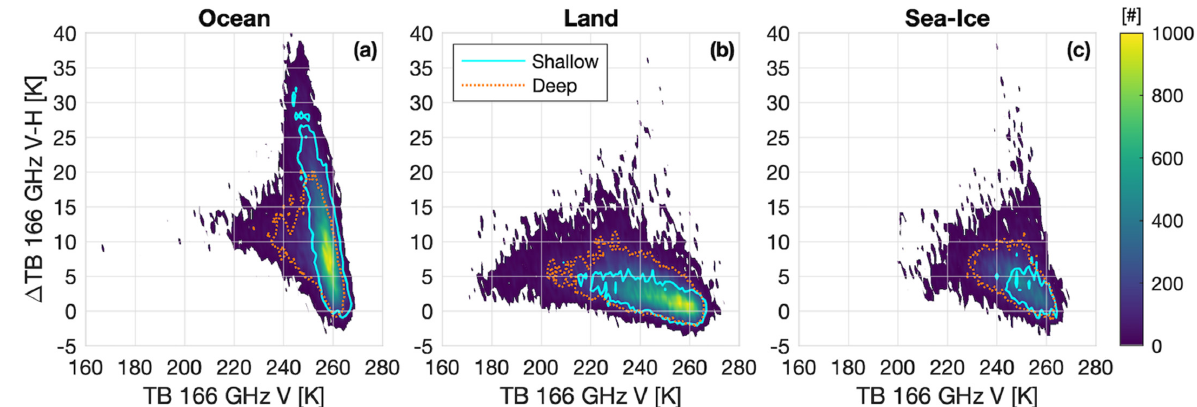
Figure 10. Two-dimensional histograms of the 166 GHz Δ TB (166V-166H difference) vs. 166 GHz TB 2-D for deep stratiform (orange dotted lines) and shallow cumuliform (cyan solid lines) over ( a ) ocean, ( b ) land and ( c ) sea-ice from GMI-CPR snowfall coincident pixels. The color bar indicates the number of occurrences, while contours indicate the bins with at least 50 counts in the two snowfall categories.